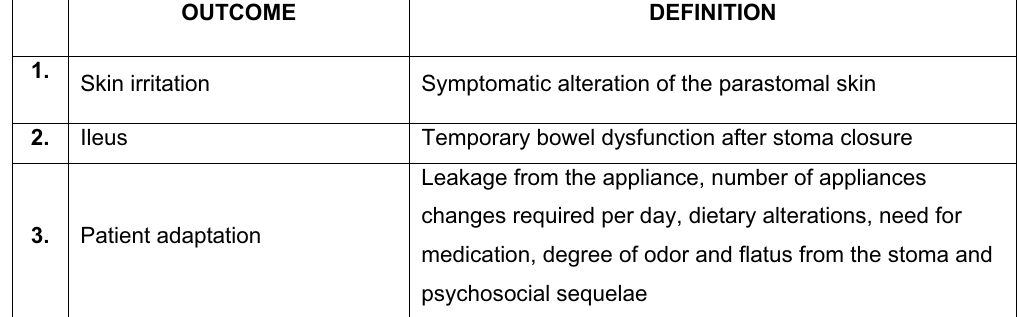
TABLE 4 - Outcome measurements relating to stoma functioning OUTCOME